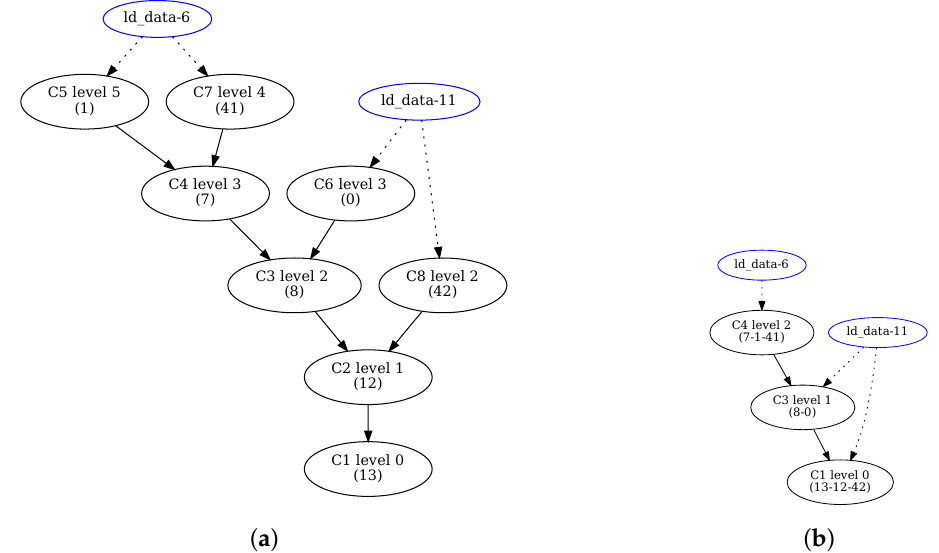
4 PE array and ( b ) 2 ×